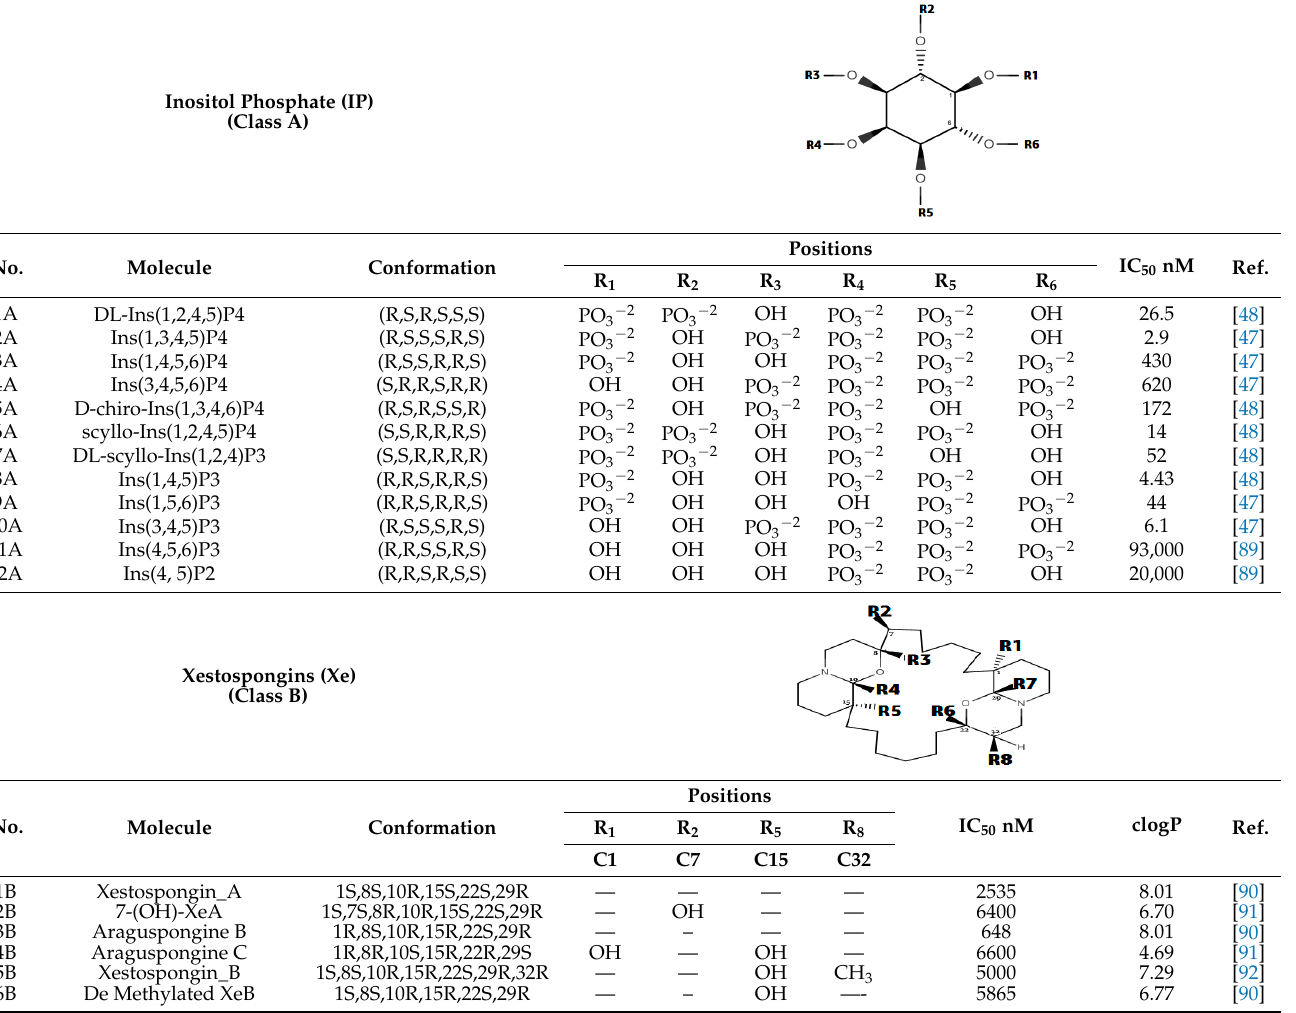
Table 2. The position specific substitutions and the stereochemistry of the compounds in class A and class B.